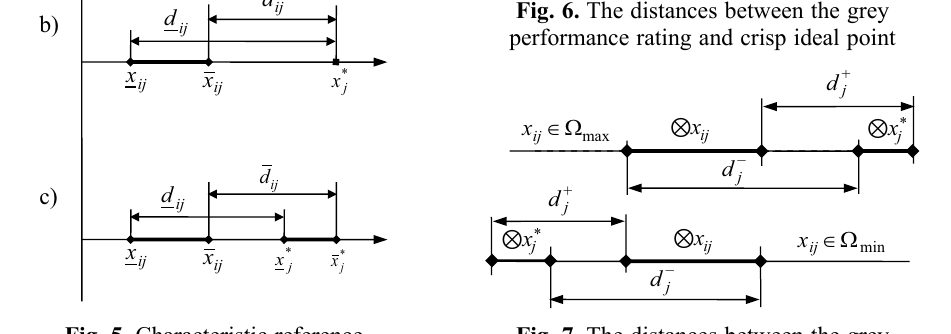
Fig. 7. The distances between the grey performance rating and grey ideal